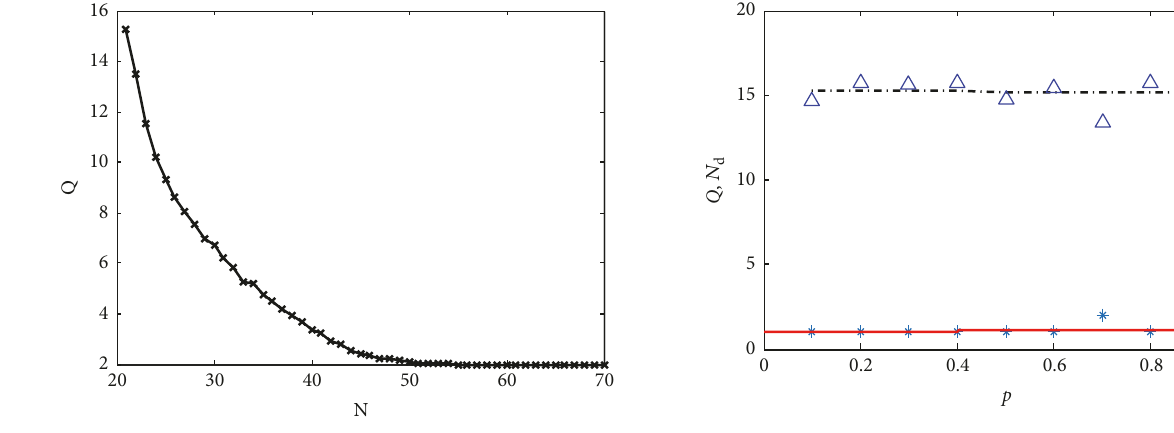
Figure 3: Trend of controllability of ER network with the number of nodes 𝑁 varying across 20, 21,.. ., 70 .